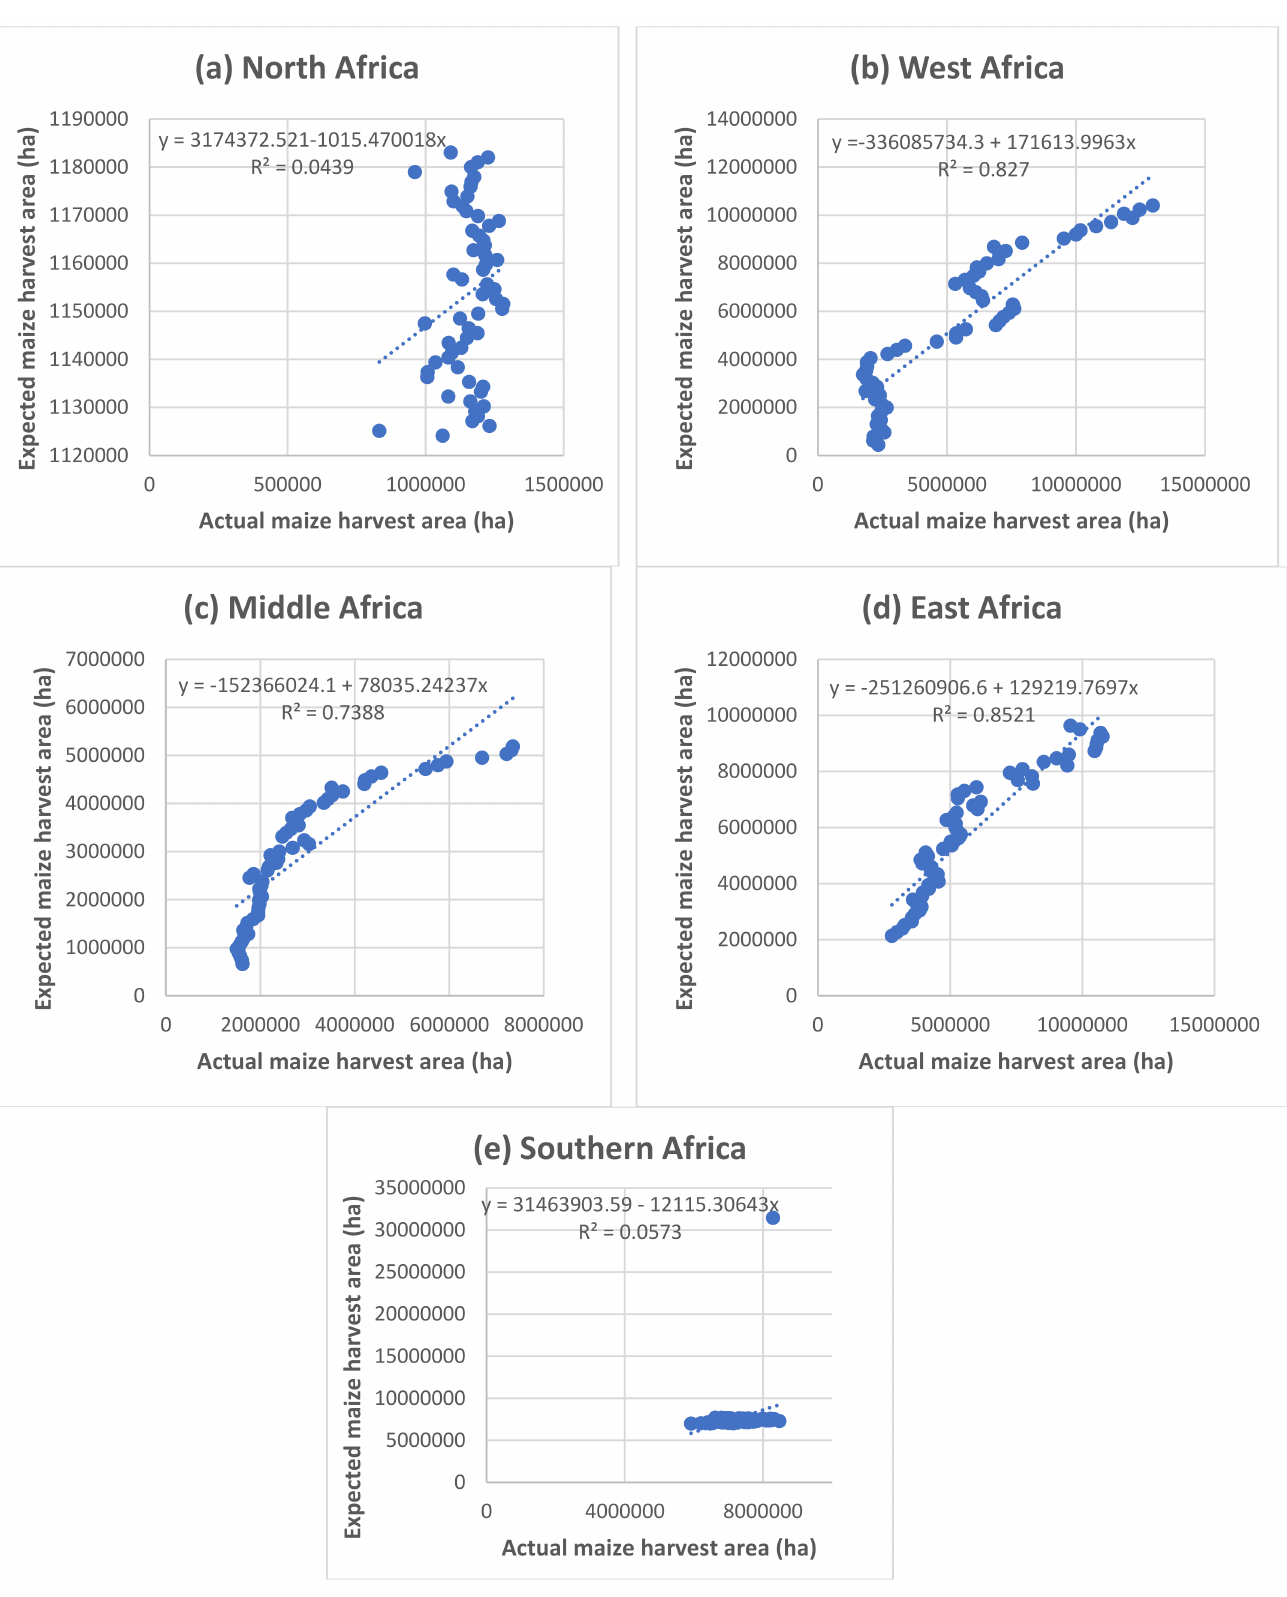
Figure 11. Scatter plots of actual and expected maize harvest area in ( a ) North Africa, ( b ), West Africa ( c ), Middle Africa, ( d ) East Africa, & ( e ) Southern